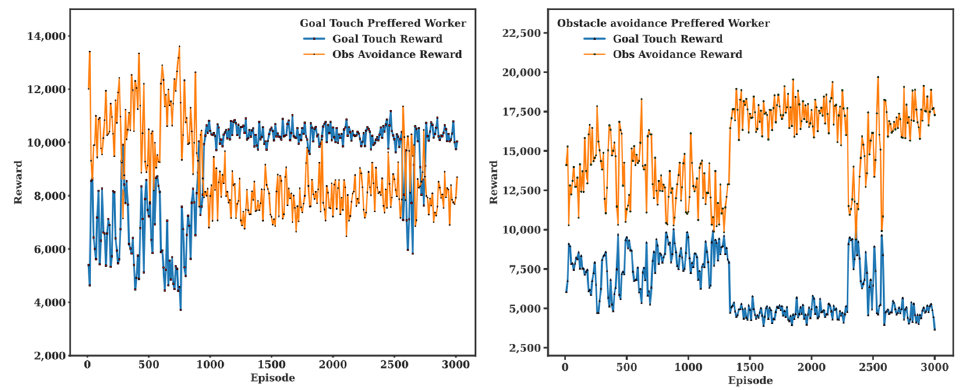
Figure 10. Biased manager